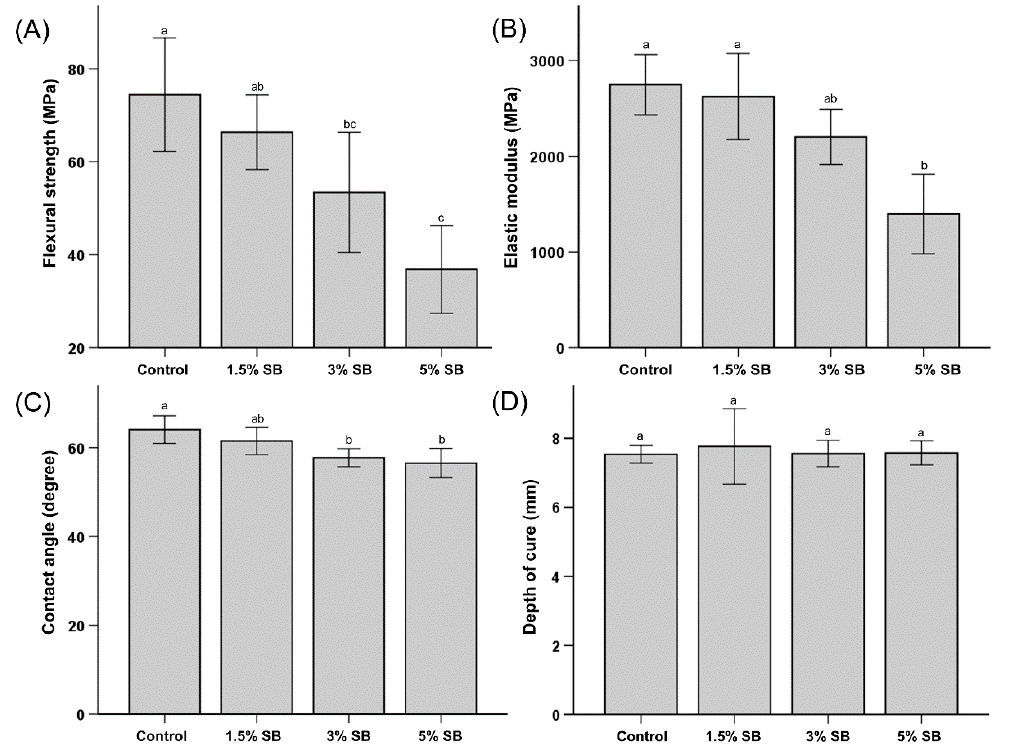
Figure 1. Comparison of the flexural strength ( A ), elastic modulus ( B ), water contact angle ( C ), and depth of cure ( D ) among different groups of samples. Different lowercase alphabetical letters above the bars indicate significant differences.